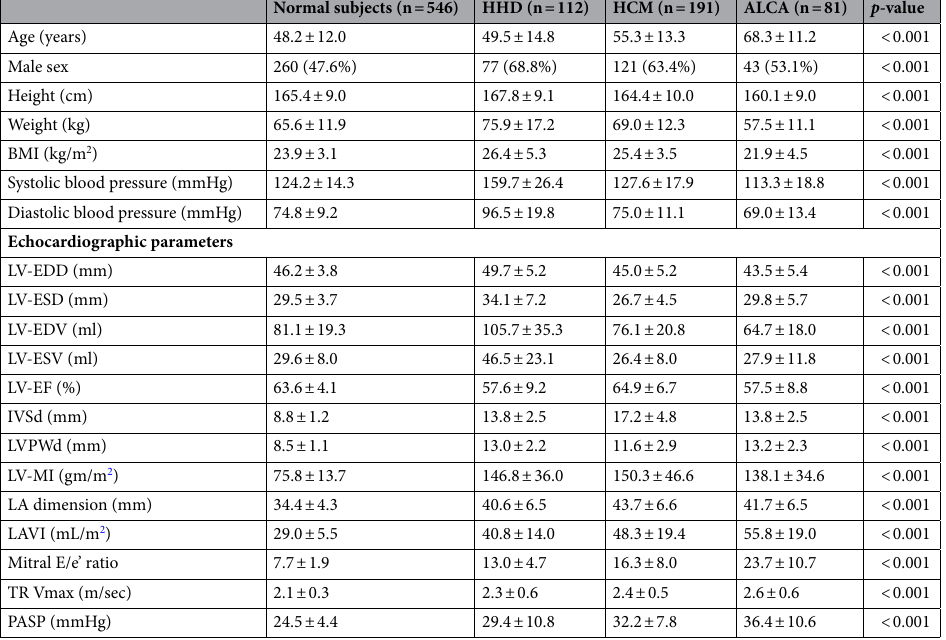
Table 1. Baseline characteristics. Values are given as the median with interquartile range or as a number (percentage). AF atrial fibrillation, BMI body-mass index, ALCA light-chain cardiac amyloidosis, EDD end- diastolic dimension, EDV end-diastolic volume, EF ejection fraction, ESD end-systolic dimension, ESV end- systolic volume, HHD hypertensive heart disease, HCM hypertrophic cardiomyopathy, IVSd interventricular septum at end-diastole, LVPWd left ventricular posterior wall thickness at end-diastole, LVWTmax end- diastolic maximal LV wall thickness, LA left atrium, LAVI left atrial volume index, LV left ventricular, MI mass index, N/A not applicable, PASP pulmonary artery systolic pressure, TR tricuspid regurgitation.